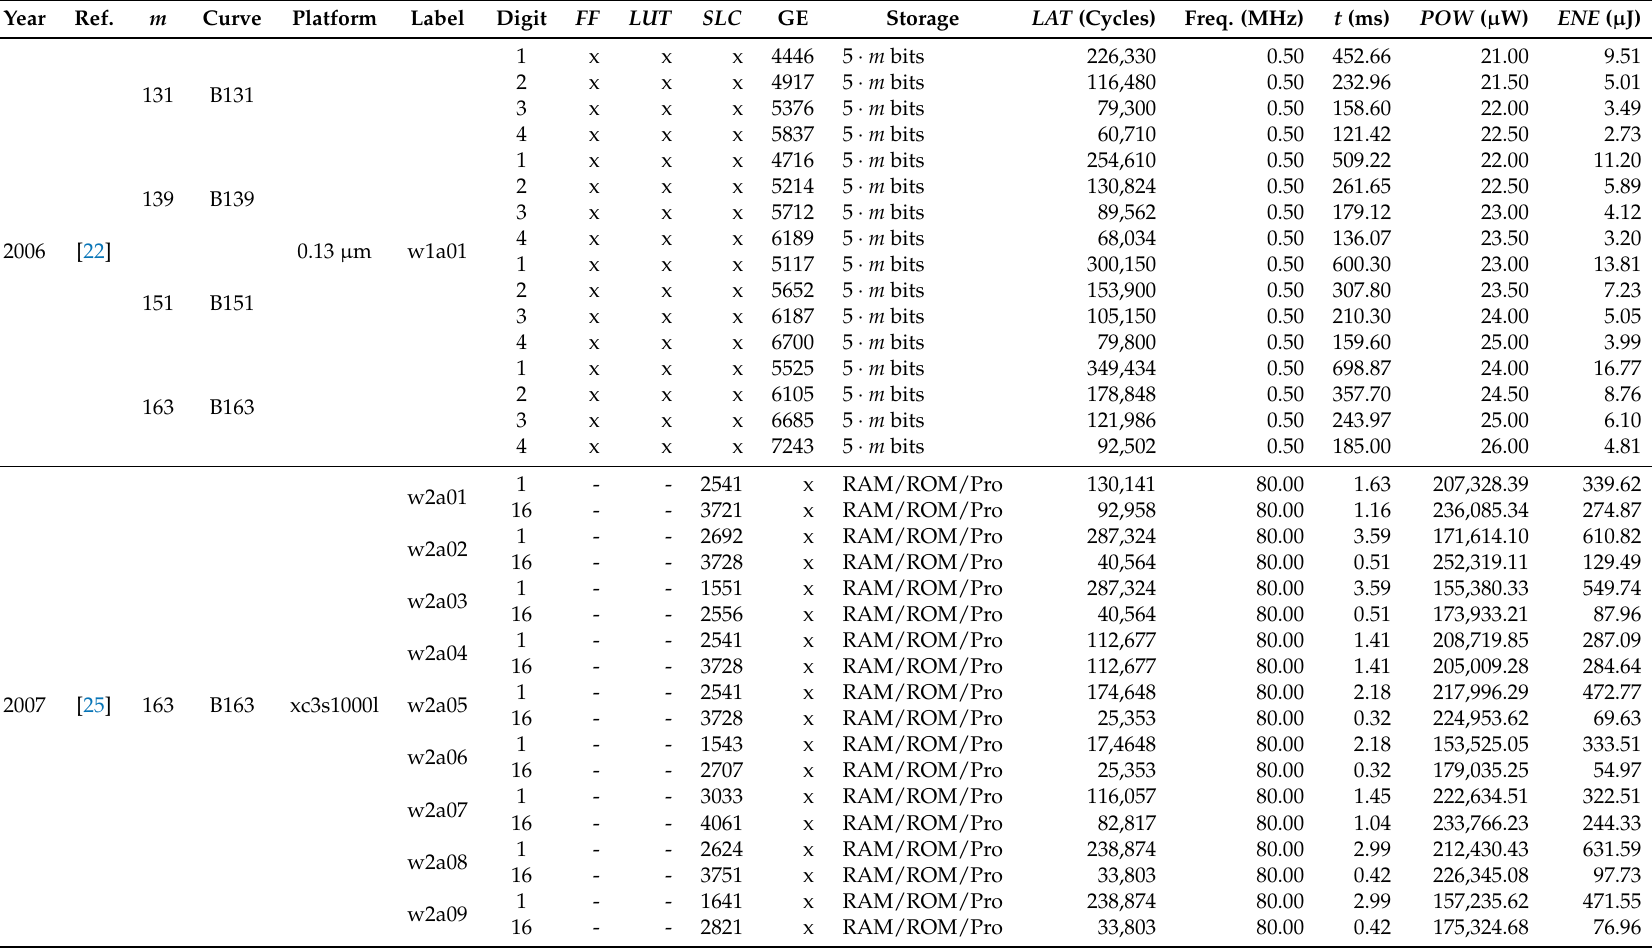
Table 8. Implementation results for different low-power or low-area kP architectures from the